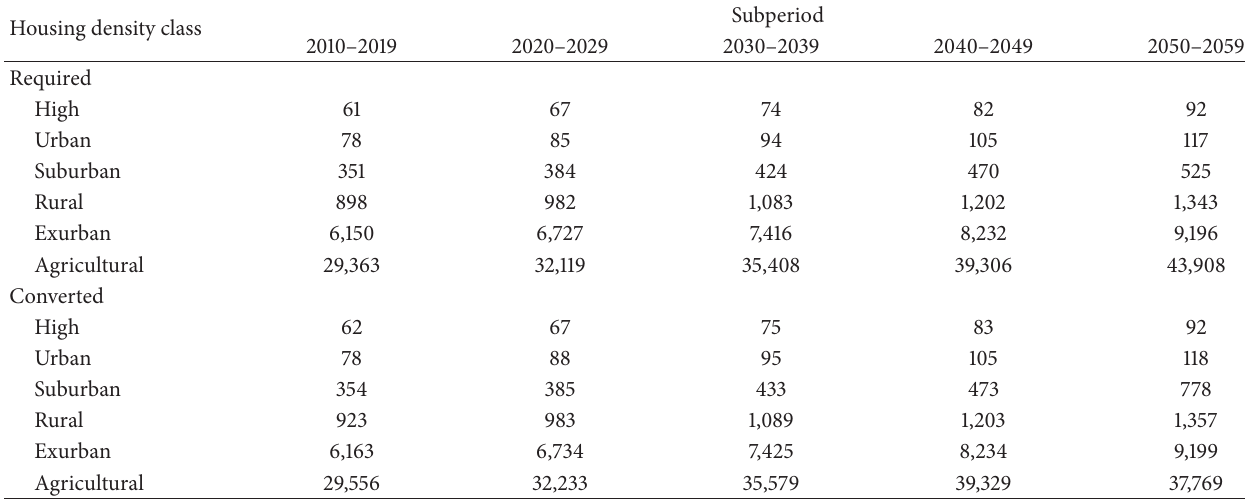
Table 1: Simulated subperiod areas of parcels required for and converted to six residential housing density classes, Flathead County, Montana, in hectares.